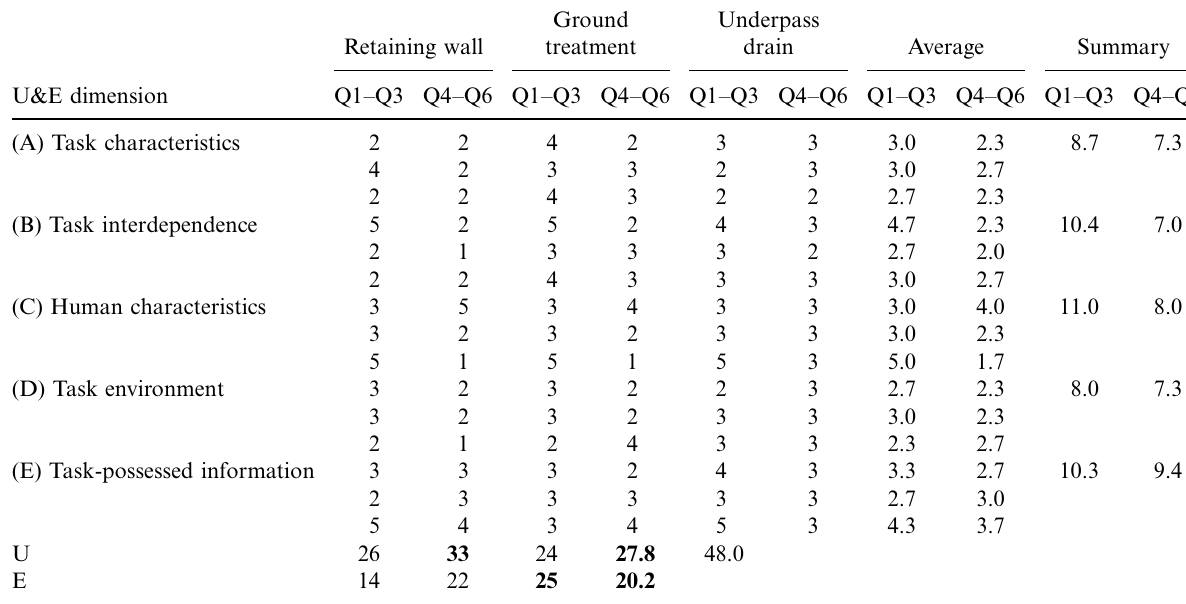
Table 4. Tasks’ U&E in the first month